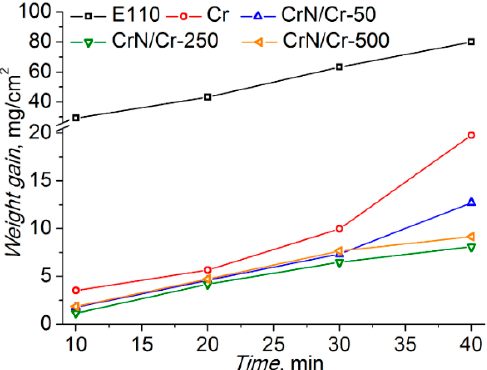
Figure 3. The weight gain of the uncoated and coated E110 alloy samples after air oxidation .